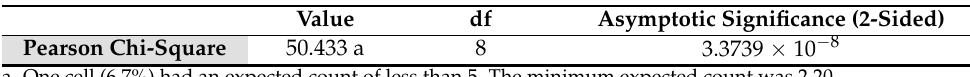
Table 13. Chi-square